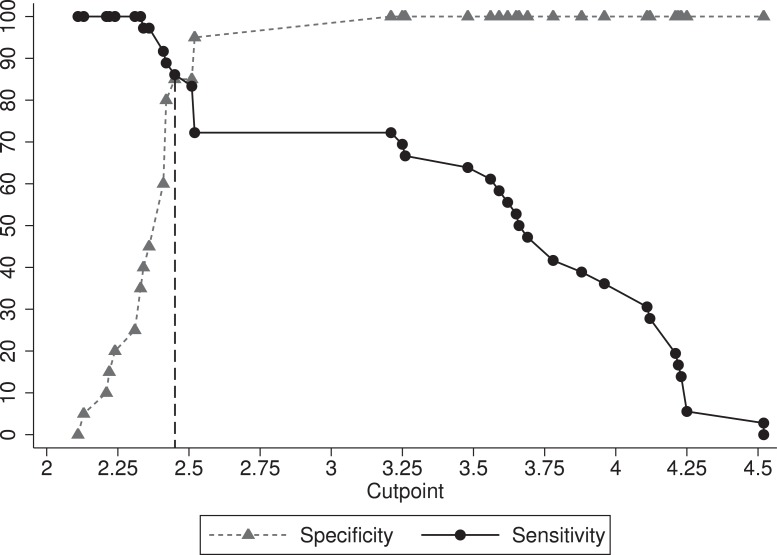
Two-graph receiver operating characteristic (TG-ROC) plot showing optimal cut-off and variation in sensitivity and specificity over various cut-off points of fibrinogen (Fb).